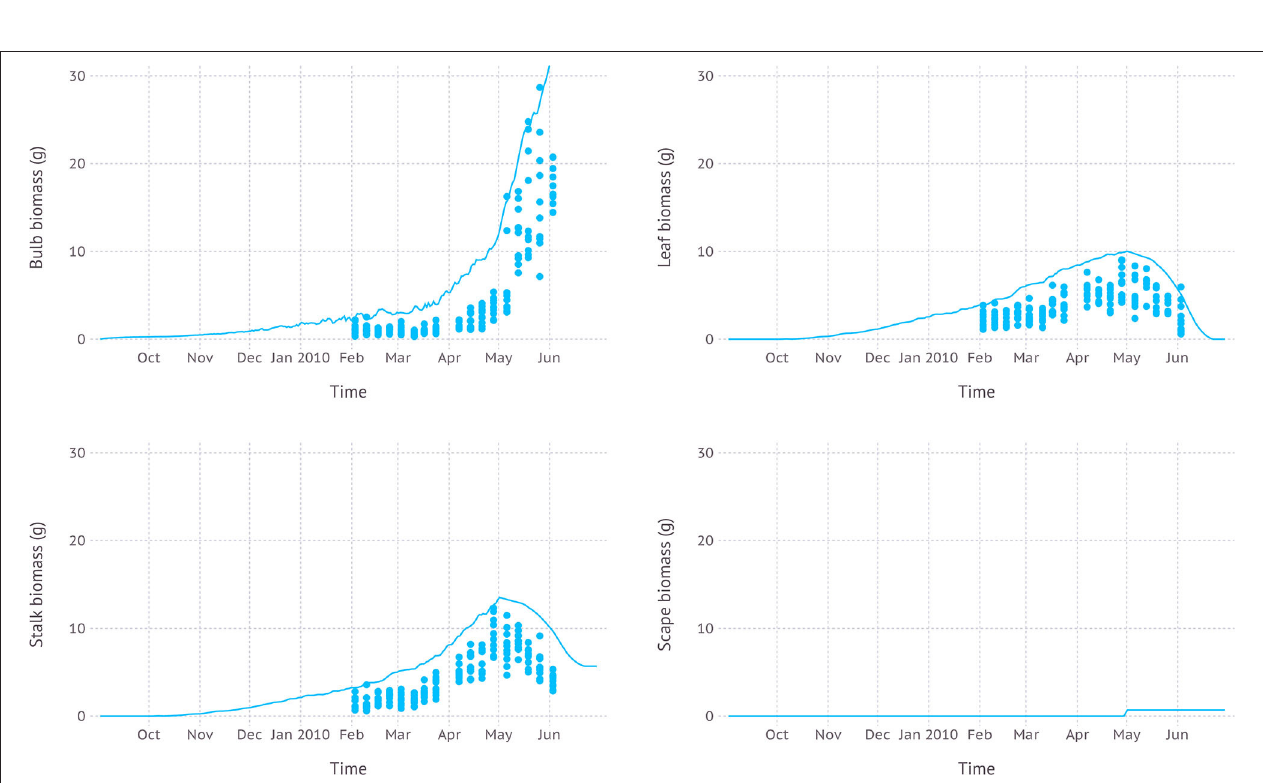
FIGURE 8 | Biomass allocation to leaf, bulb, stalk, and visible portion of scape simulated over time compared with measurements from dataset D3 which was from field measurements with scape removal.